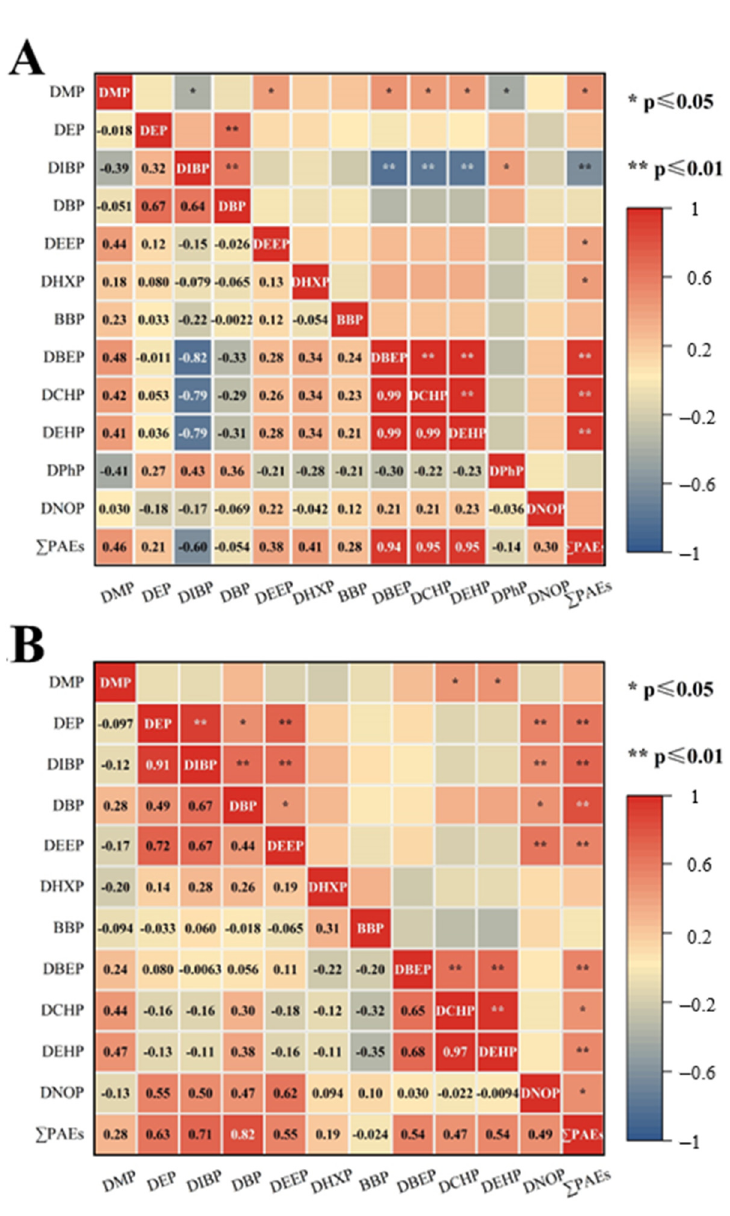
Figure 3. Pearson correlation analysis between individual PAE and ∑ PAEs in October ( A ) and May ( B ). **: the correlation was significant at p ≤ 0.01 level. *: the correlation was significant at p ≤ 0.05 level.